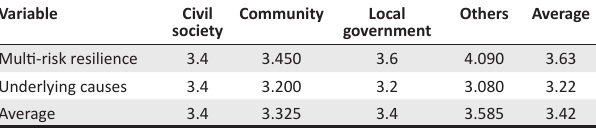
TABLE 1: Participants views on context of